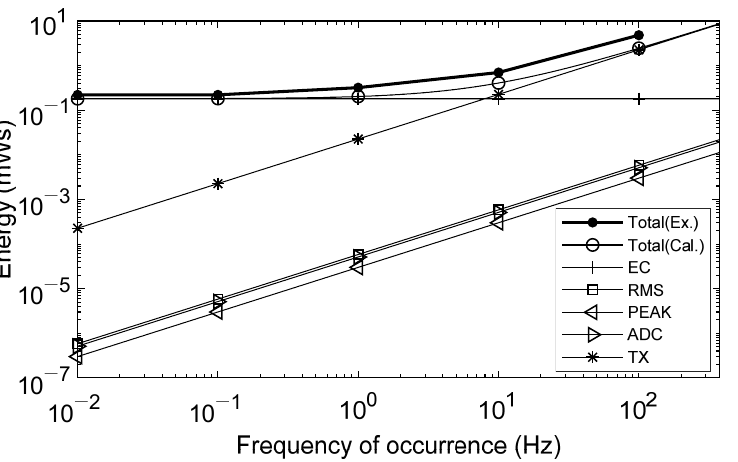
Figure 17. Energy consumption of the proposed event-driven monitoring system as a function of abnormal input occurrence frequency.